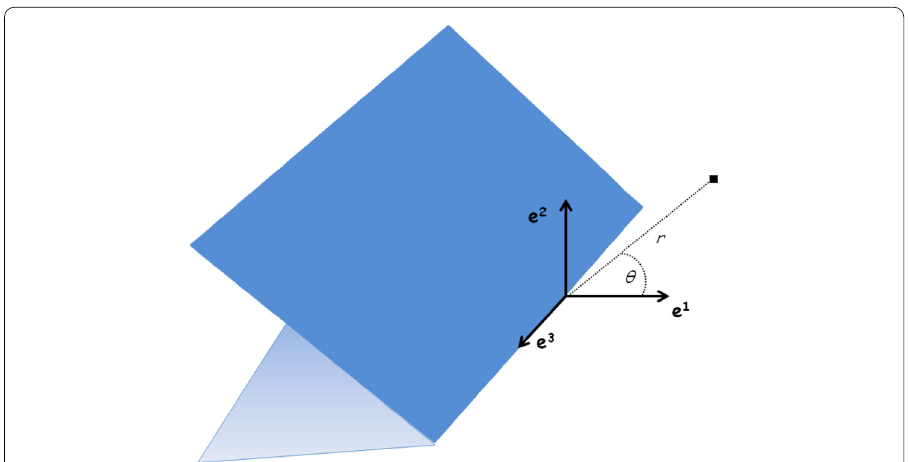
Fig. 4 Plane crack local basis at the crack-tip. Definition of cylindrical coordinates at the crack-tip for plane crack